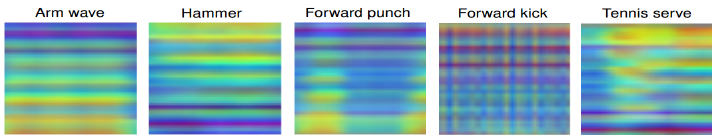
Figure 4. Immediate image-based representations for the recognition stage.